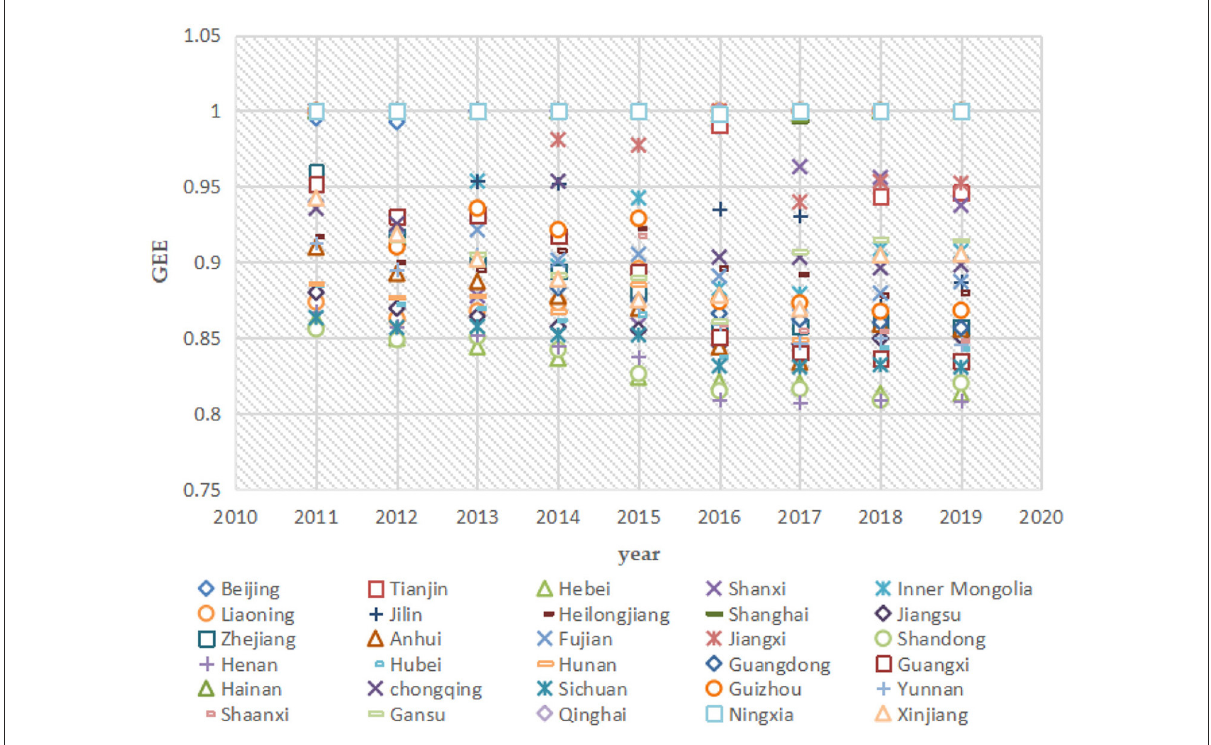
FIGURE8 Green economic efficiency in 30 Chinese provinces, 2011 to